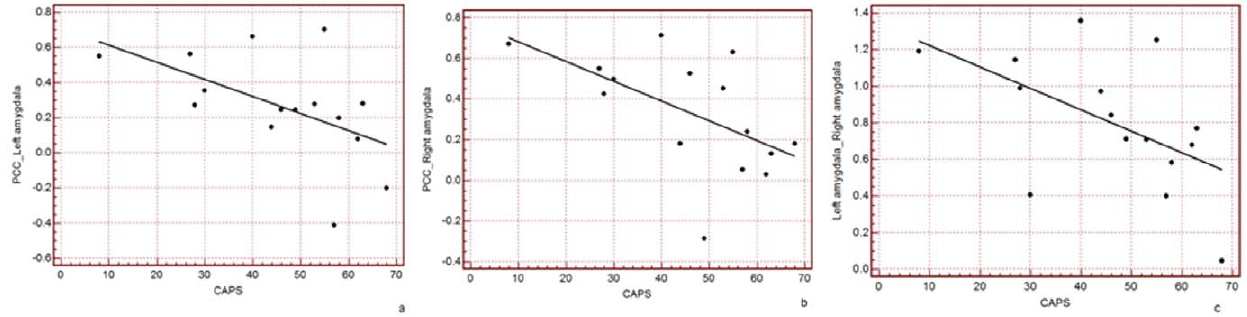
Figure 2. Correlation between PCC-left amygdala, PCC-right amygdala, left-right amygdala connectivity and CAPS in 15 PTSD patients: (Fig. 2a) PCC-left amygdala connectivity and CAPS, r= 2 0.53, p=0.04; (Fig. 2b) PCC-right amygdala connectivity and CAPS, r= 2 0.57, p=0.03; (Fig. 2c) left-right amygdala connectivity and CAPS, r= 2 0.54, p=0.04. doi:10.1371/journal.pone.0046833.g002 PLOS ONE |